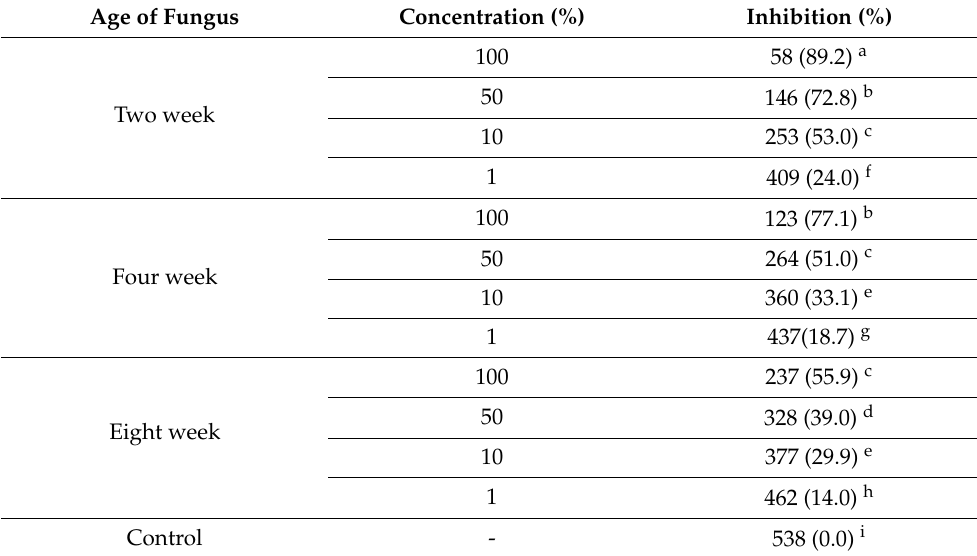
Table 1. Effect of different stages of pileus of Ganoderma lucidum on egg hatching inhibition of root-knot nematode, Meloidogyne incognita . Age of Fungus Concentration (%) Inhibition (%) 100 58 (89.2) a 50 146 (72.8) Two week